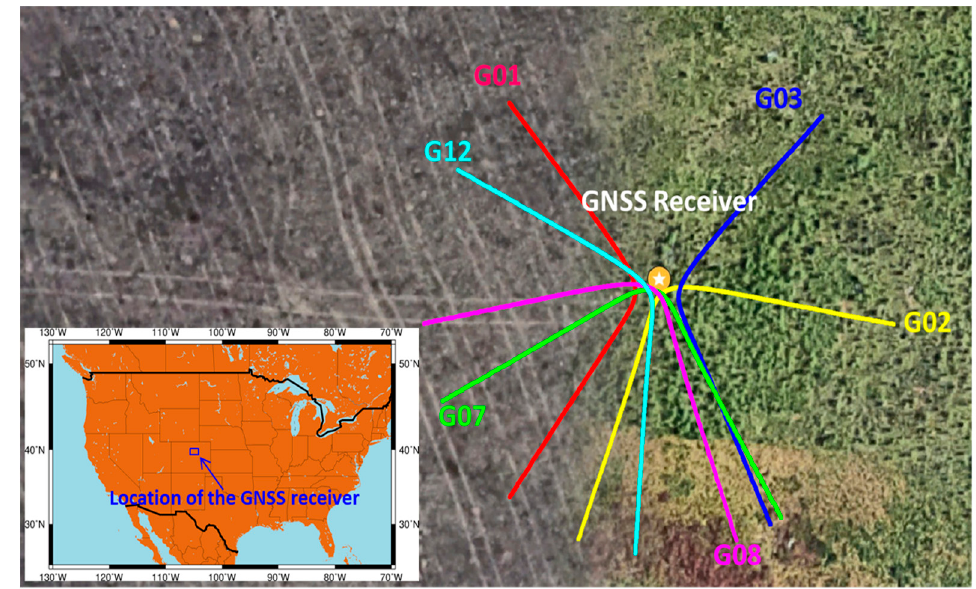
Figure 5. The MFLE station is located in Boulder, Colorado. Some GPS satellites ground reflected tracks showed in the figure.